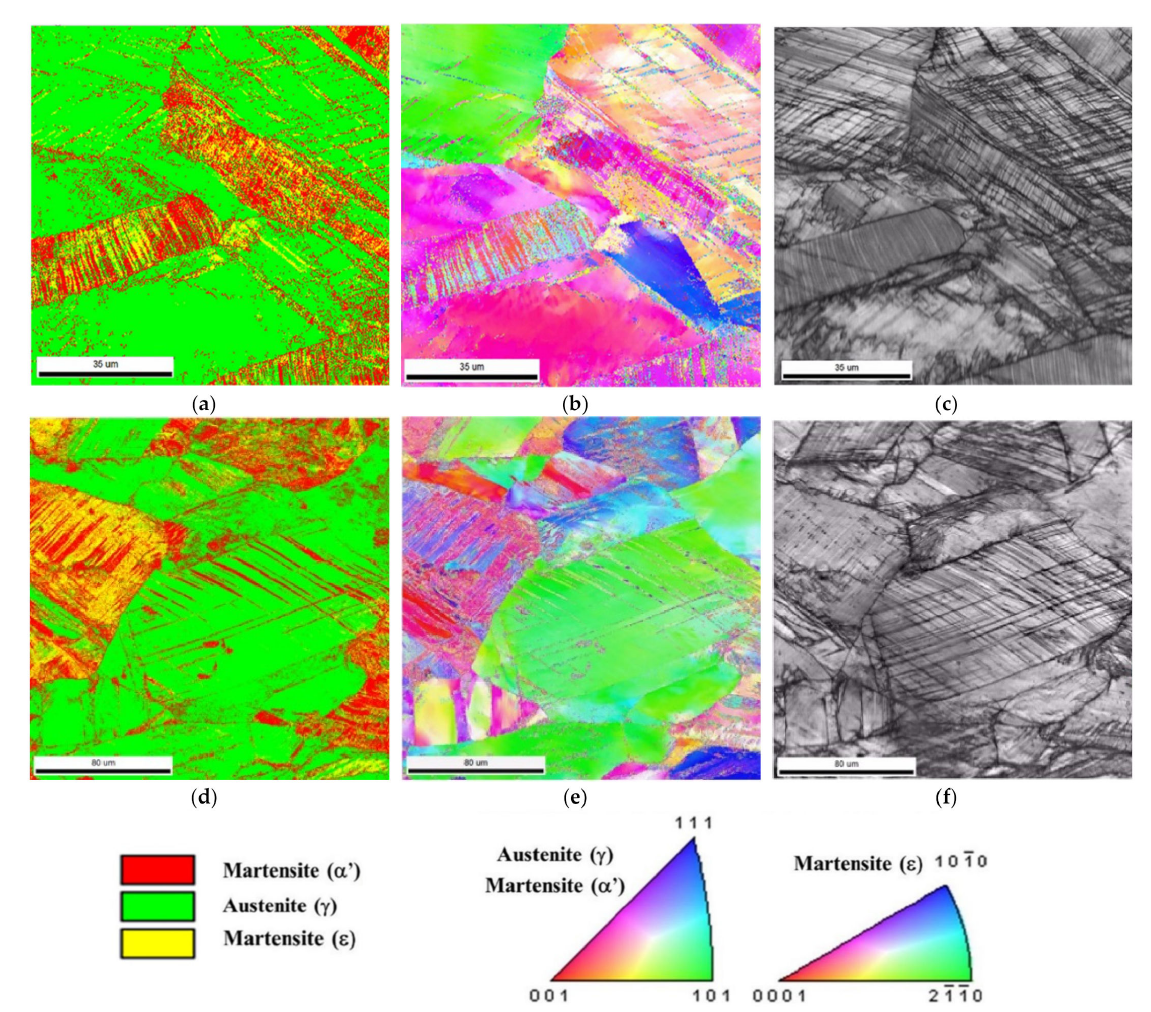
Figure 15. Microstructure of Fe-Mn-Al-Si steel after 30% of tensile deformation ( a , d ) phase maps (FCC austenite—green, HCP martensite—yellow and BCC martensite—red color), ( b , e ) IPF maps and ( c , f ) band